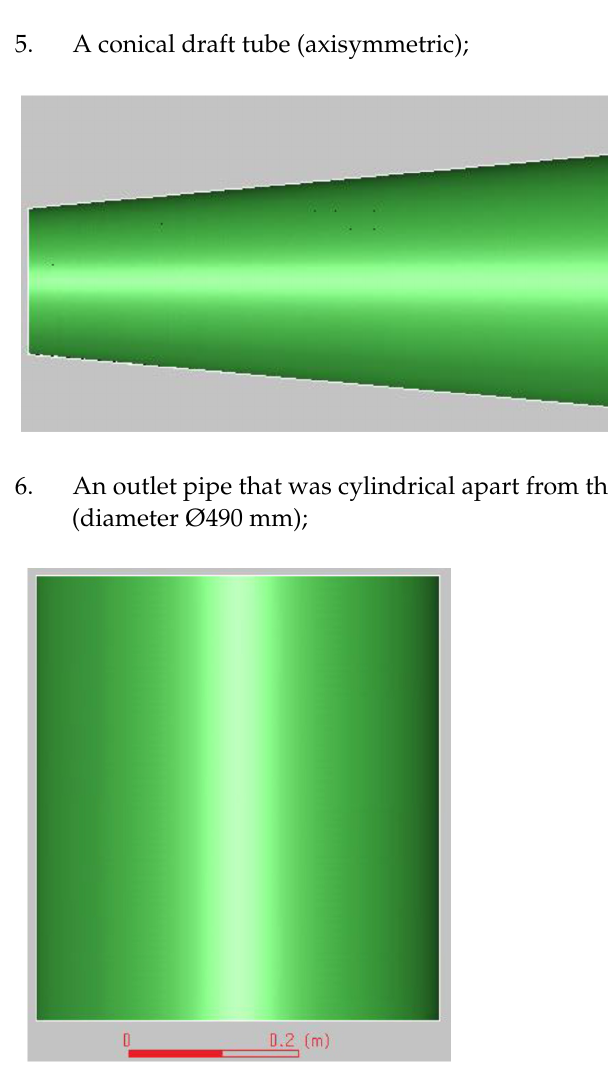
Figure 7. Model turbine runner blade of the semi-Kaplan turbine in an isometric view and shown from above. The calculations were made using the ANSYS/Fluent™ software, assuming the incompressibility of water (density ρ = const) and its viscosity for the assumed temperature of 15 °C (dynamic viscosity μ ≠ 0). The calculations used: − second-order discretization, i.e., the scheme of ‘second-order upwind’; − double-precision when solving; − at least 8000 iterations for each case;